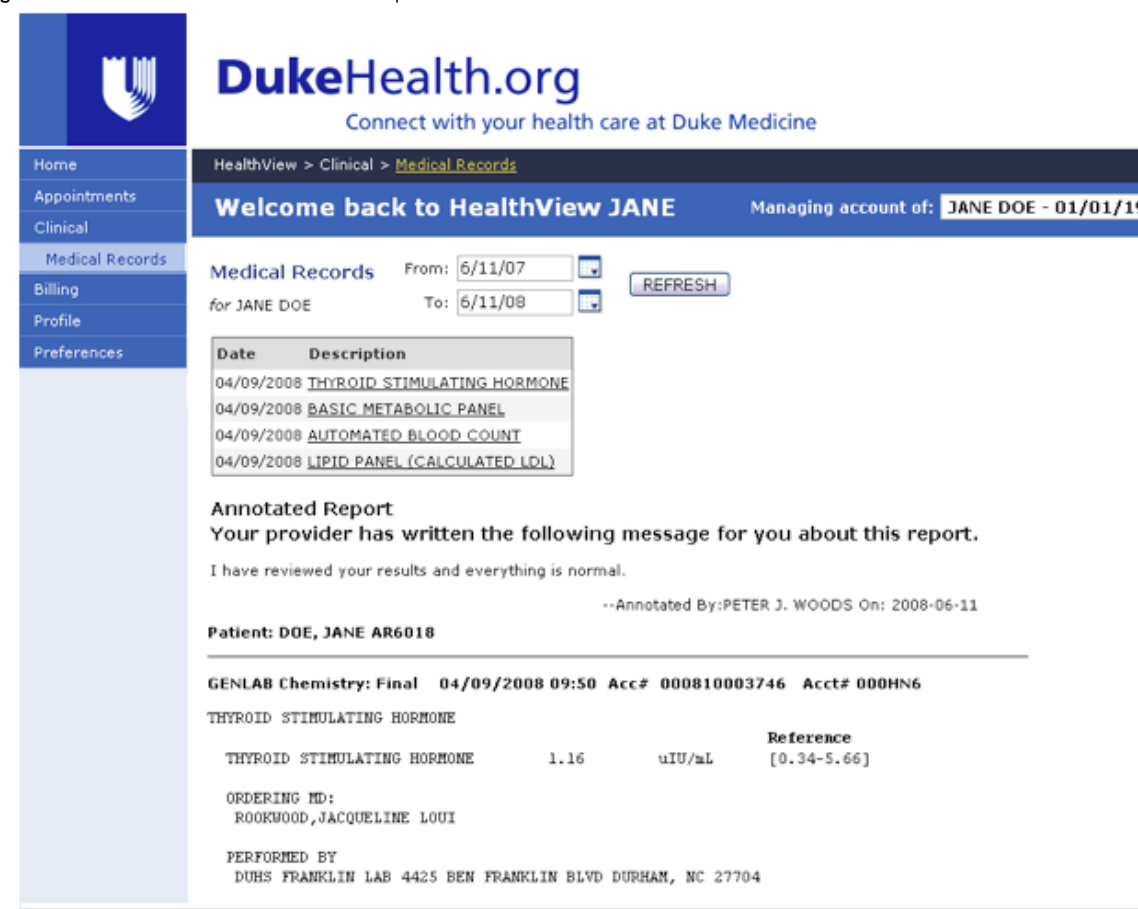
Figure 1. Screenshot of the DUHS HealthView